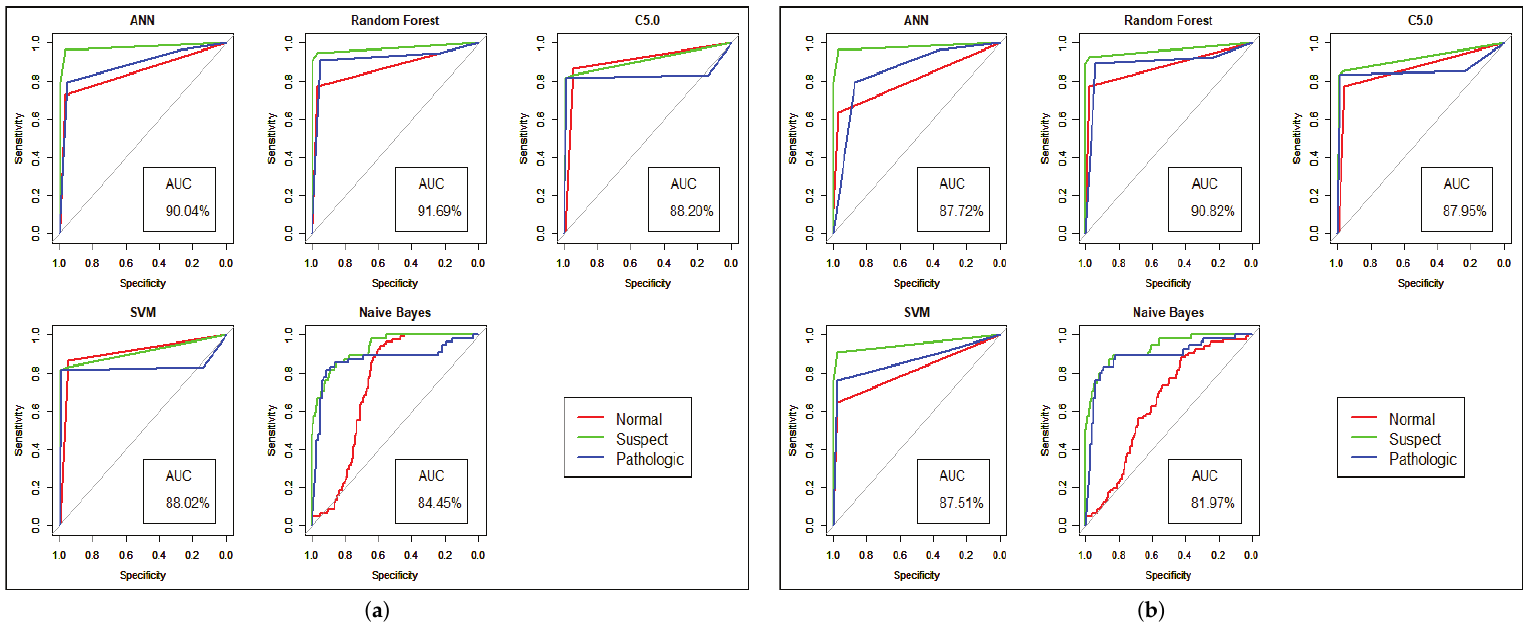
Figure 8. Model Performance with ROC curve for CTG prediction. ( a ) Performance before Genetic Algorithm. ( b ) Performance after Genetic